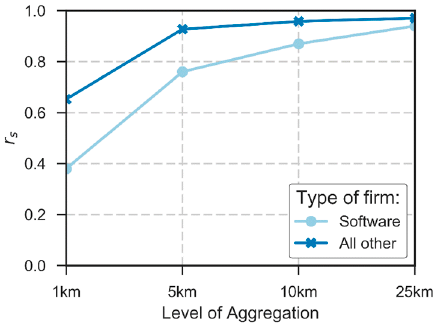
Figure 3. Correlation (r s ) between firm counts and population numbers by level of aggregation.